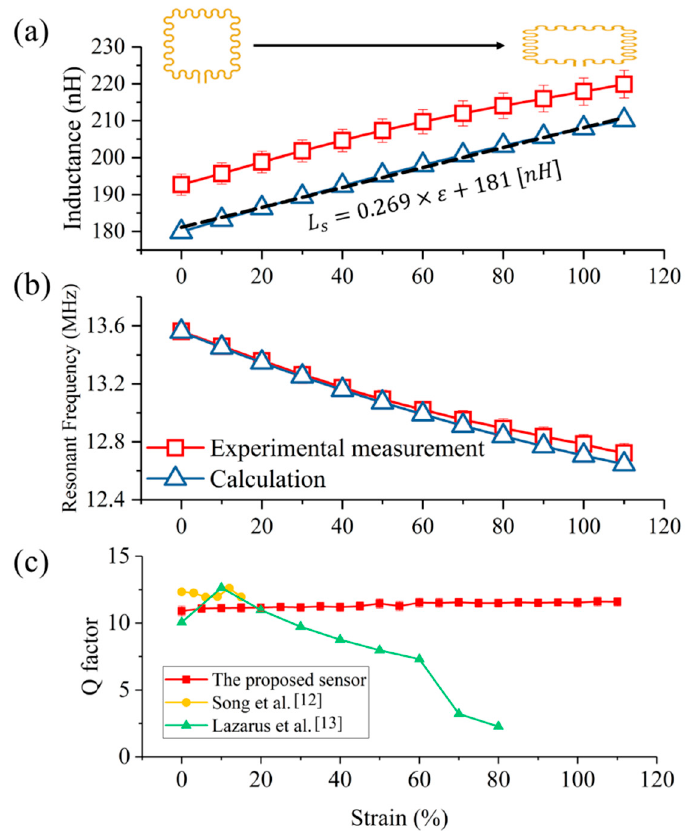
Figure 7. ( a ) Inductance change and ( b ) shift in resonant frequency of the sensor according to